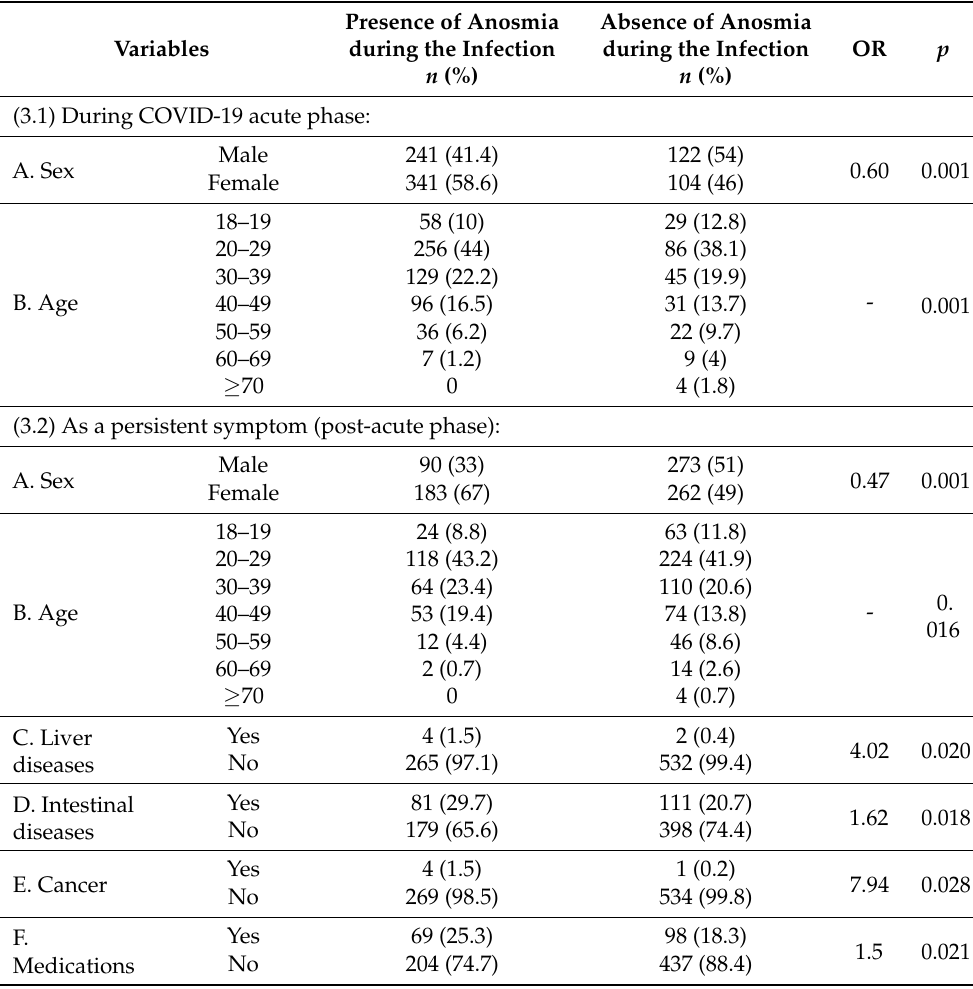
Figure 2. The association between the use of treatments and the duration of persistent anosmia and/or ageusia ( p = 0.002).